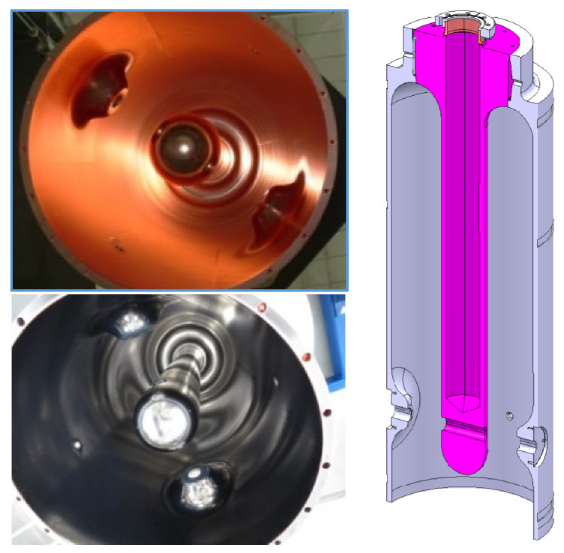
FIG. 1. The HIE-ISOLDE QWR cavities, before (top left) and after (bottom left) coating, and 3D illustration of the cavity geometry